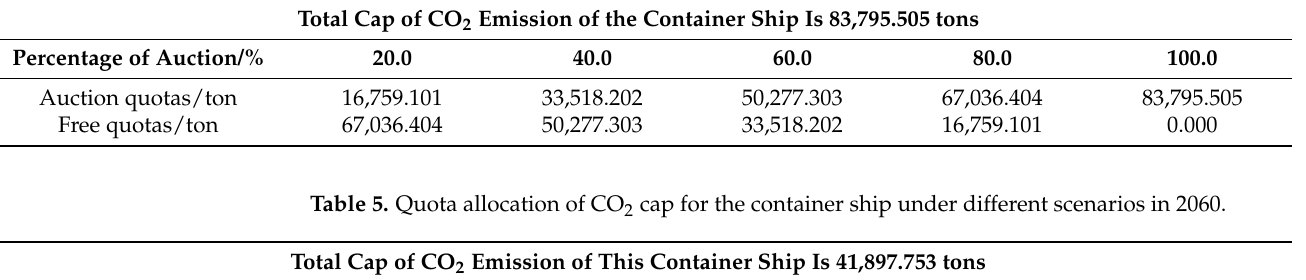
Table 4. Quota allocation of CO 2 cap for the container ship under different scenarios in 2030.